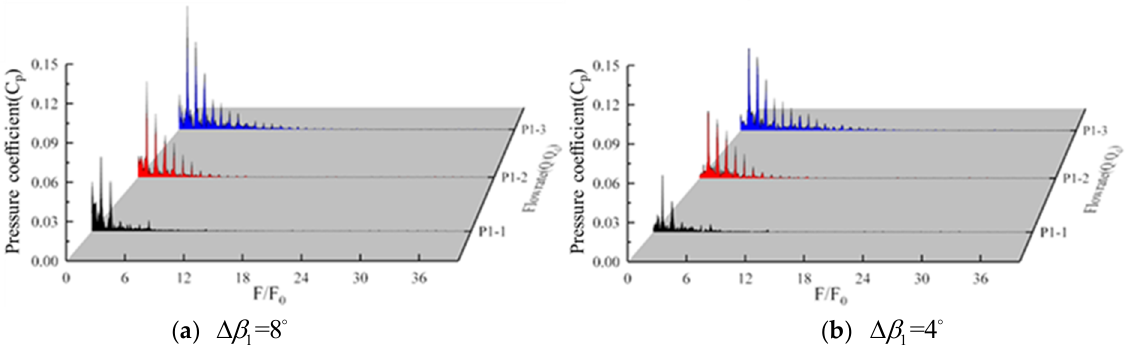
Figure 19. Frequency domain characteristics of monitoring points at pressure surface of blade when 0.5Q.